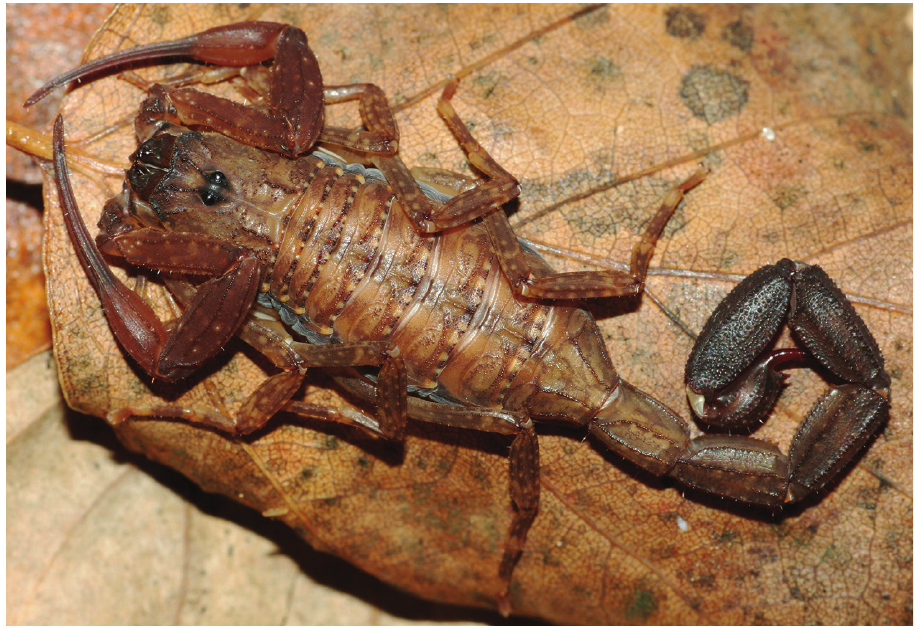
Figure 13. Tityus obscurus , juvenile from Saut